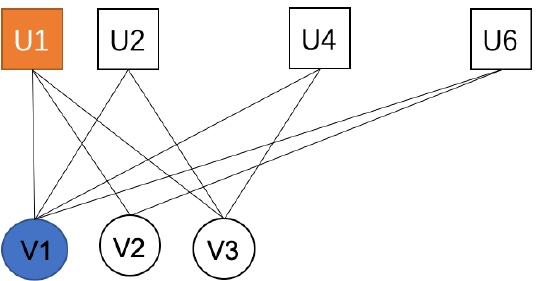
Figure 4. A set NeiPN ( U 1, V 1 ) of neighbor node pairs of node pairs ( U 1, V 1 ) . In a bipartite network G = ( U , V , E ) , assume that the bipartite network G is divided into X communities, where the t -th community is expressed as G t = ( U t , V t , E t ) , and ϕ ( u , v ) represents whether the node pair ( u , v ) is a node pair within the community. D t ( m , n ) ( m ) ϕ ( m , v k ) , represents the node pair density of node pairs ( m , n ) in community G t ; in ∑ L k = 1 L ( m ) represents the total number of all V nodes connected to m, k represents the serial number of node v k connected to m, and, when k = 1, it means that m is connected to V node v 1 . For node pair ( m , v k ) , if they are edges e ( within the t -th community, then m , v k ) ϕ ( m , v k ) = 1. We express these